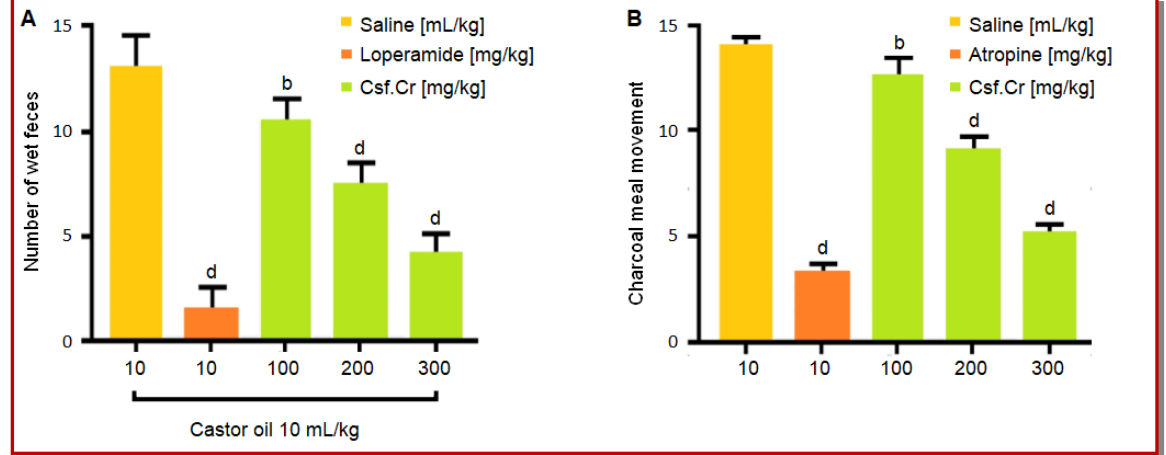
Figure 4: Dose dependent inhibitory effect of crude extract of C. siliqua on (A) castor oil-induced diarrhea in mice n=5, (B) Char- coal meal propulsion in mice n=5. a (p< 0.05), b (p< 0.01), c (p< 0.001), d (p< 0.0001) were considered statistically significant followed by One-Way-Analysis of variance (ANOVA)